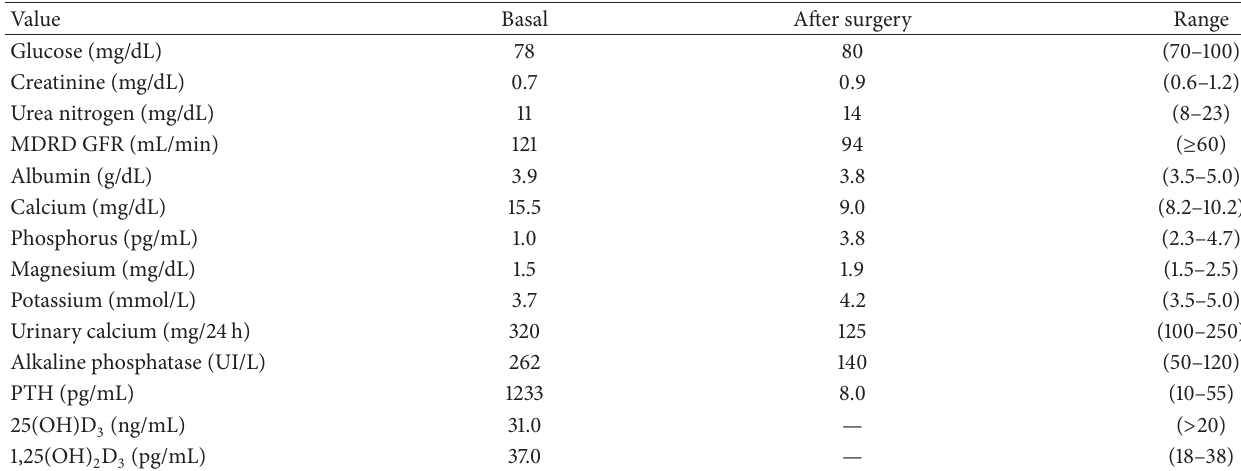
Figure 1: Computed tomography of skull that shows a heterogeneous, osteolytic lesion that involves sphenoid corpus and clivus. (a) Sagittal section. (b) Axial section. Table 1: Laboratory